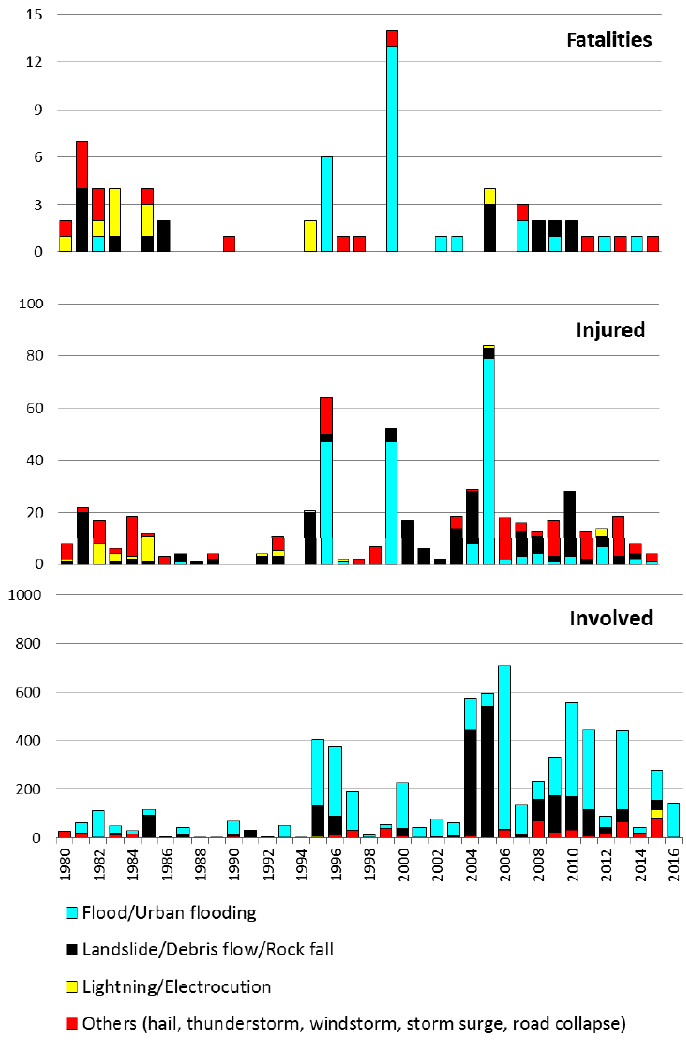
Figure 2. Yearly trend of fatalities, injured and involved people during the period 1980–2016.